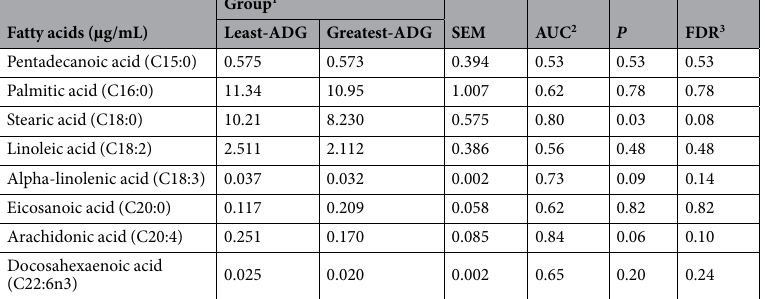
Table 5. Fatty acid concentrations in plasma on steers with the least and greatest average daily gain. 1 Groups were least-ADG steers ( n = 8), with the least average daily gain, and greatest-ADG steers ( n = 8), with the greatest average daily gain, with groups having similar dry matter intake. 2 AUC = area under the curve calculated by receiver-operator characteristic curve analysis. 3 FDR = false discovery rate p